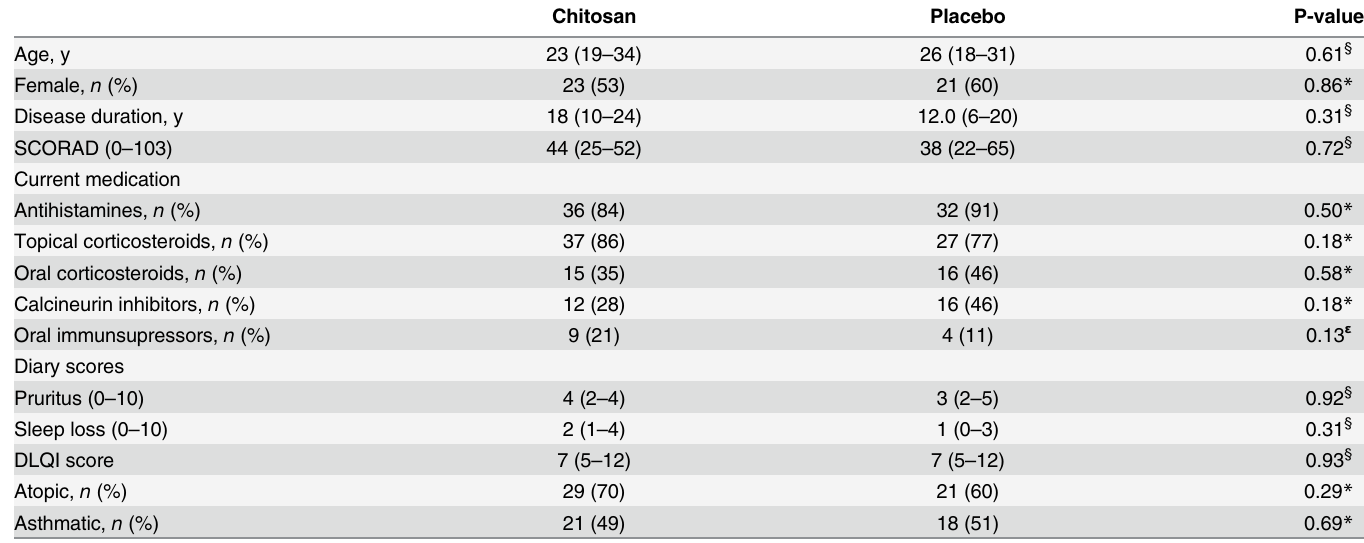
Table 1. Baseline characteristics of atopic dermatitis patients by chitosan intervention group ( N = 43) and placebo group ( N = 35). Chitosan Placebo